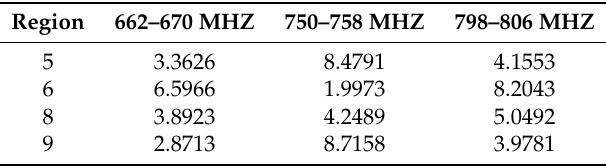
Table 1. The sensing reports of sensor nodes (5, 6, 8,